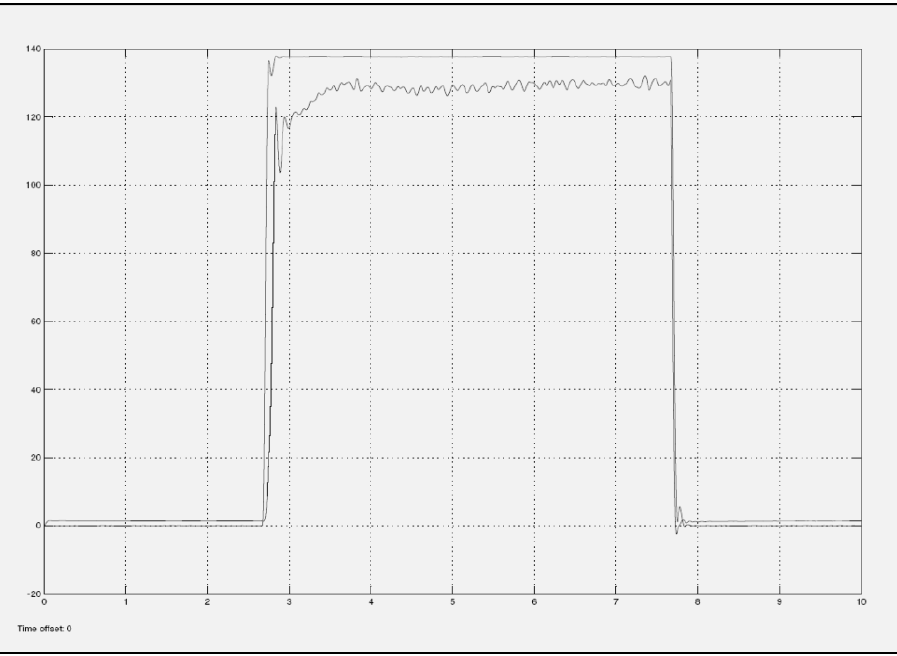
Figure 10. Return EFC Valve with 1.8 Amps current